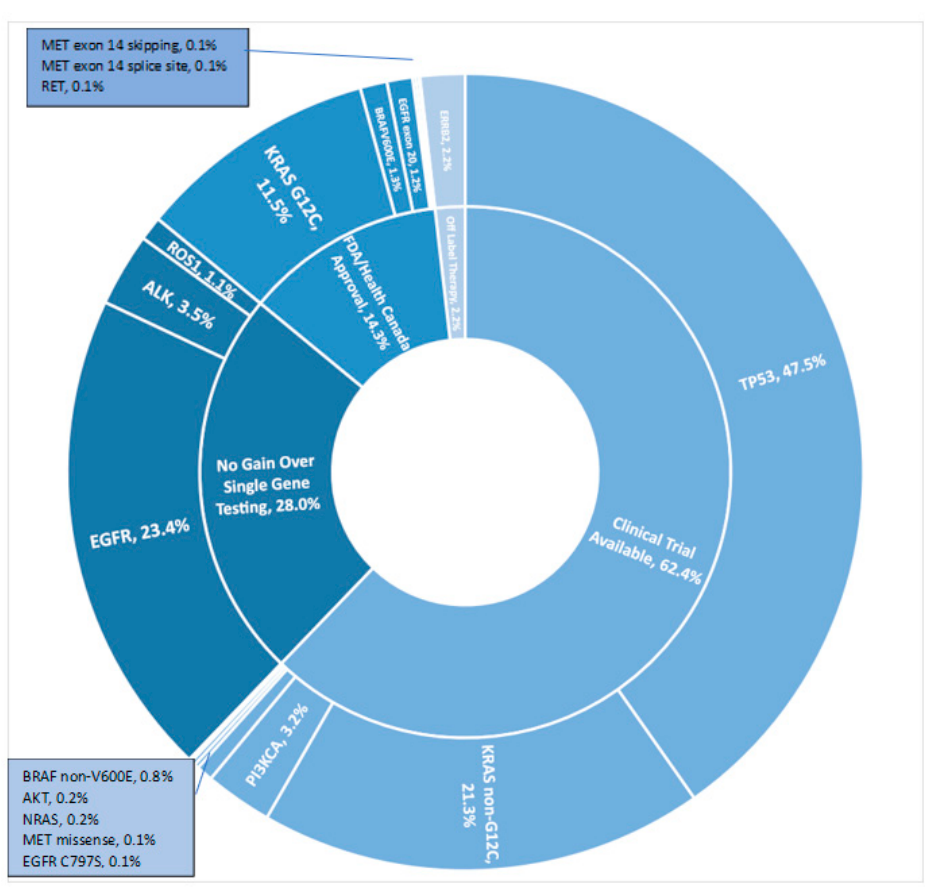
Figure 3. Incremental clinical benefit from use of 15-gene panel versus single gene testing.